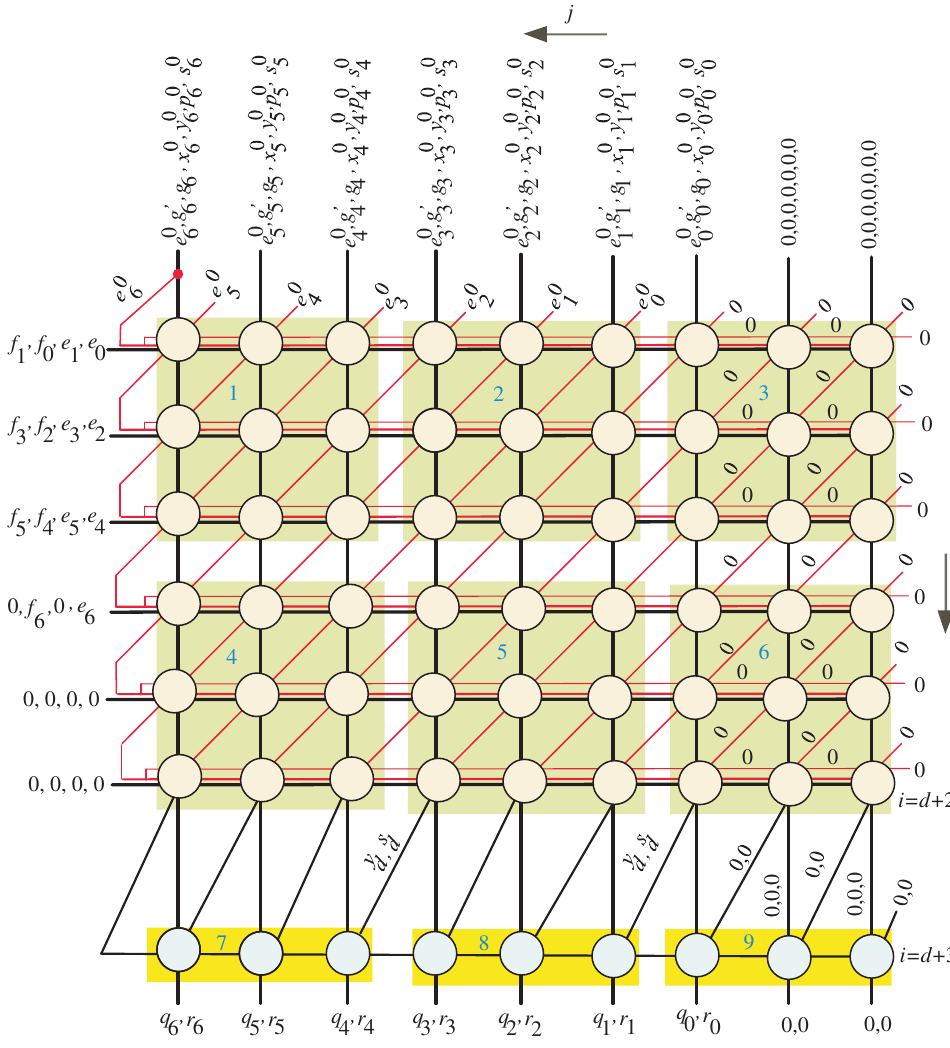
Figure 2. Scheduling time for the case when n = 7 and k =